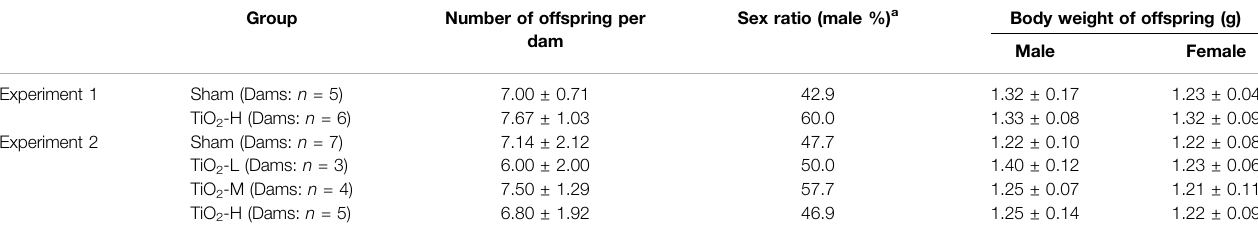
TABLE 1 | Number, sex ratio, and body weight of 1-day-old offspring. Group